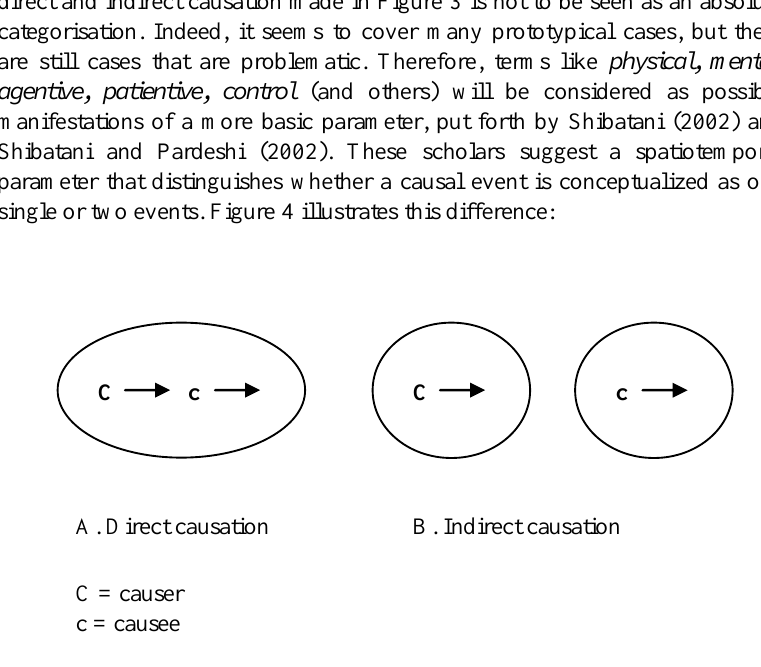
Figure 4. Direct and indirect causation (cf. Shibatani & Padeshi, 2002: